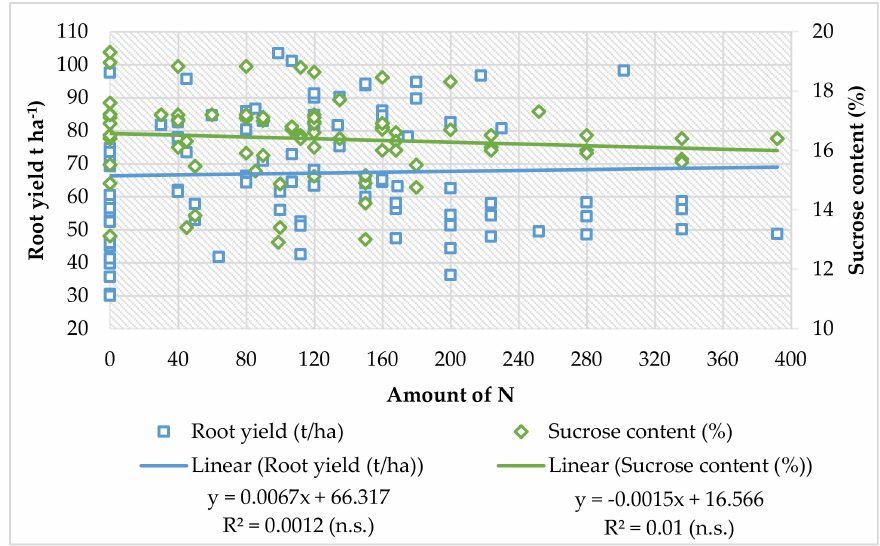
Figure 1. Linear regression models of sugar beet root yield and sucrose content (data obtained from: Malnou et al. [16], Marinkovi´c et al. [90,93], Mili´c et al. [124], Pogłodzi´nski et al. [130], Varga et al. [134], Barł ó g et al. [85], Lentz and Lehrsch [137] Carter and Traveller [23], Tarkalson et al. [22], Lauer